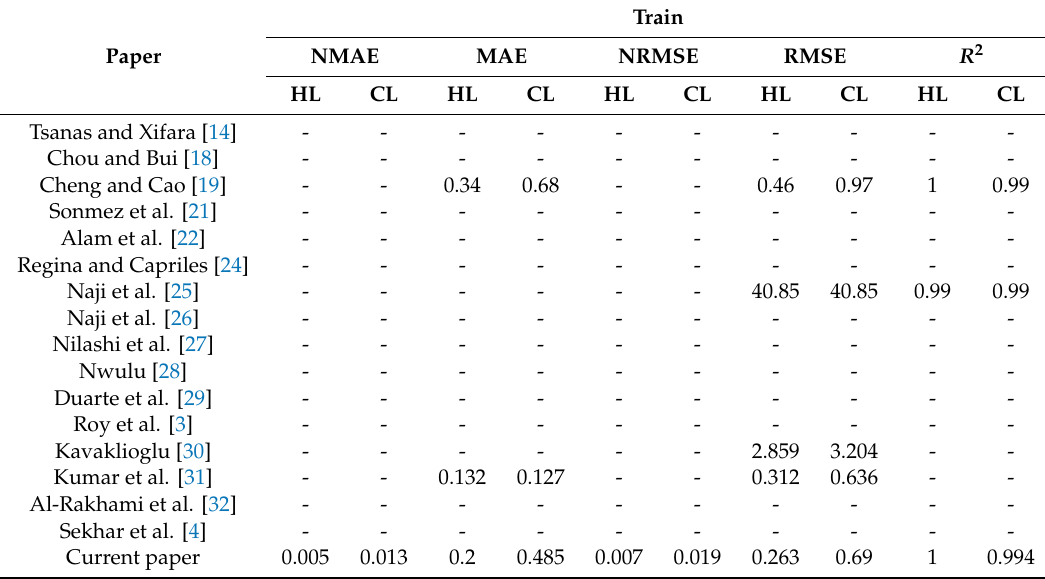
Table 6. Comparison of performance measures in training data. “NMAE” stands for normalized MAE and “NRMSE” stands for normalized RMSE.